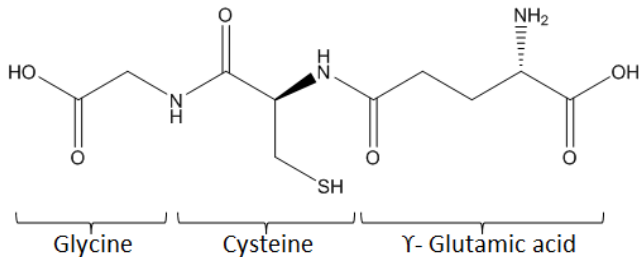
Figure 8. Structure of glutathione.